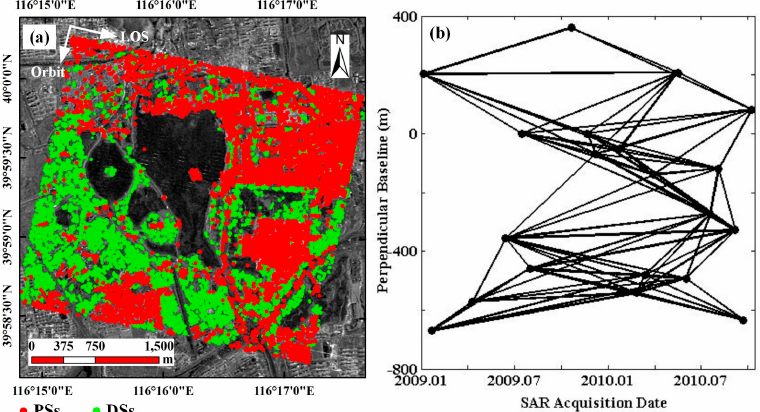
Figure 4. ( a ) Distribution of Persistent Scatterers (PSs) and Distributed Scatterers (DSs) in the Summer Palace and its surroundings; and ( b ) interferograms with spatial and temporal baselines (circles indicate SAR acquisitions).